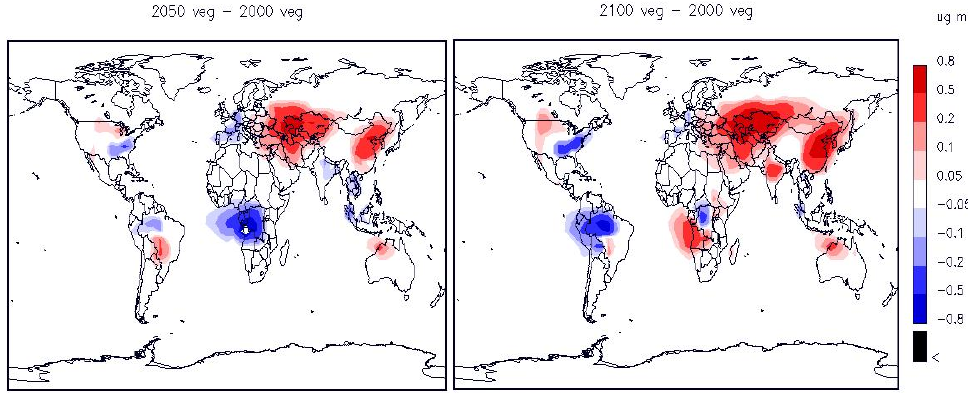
Figure 6. Same as Figure 5 but for surface secondary organic aerosols. Color scales saturate.